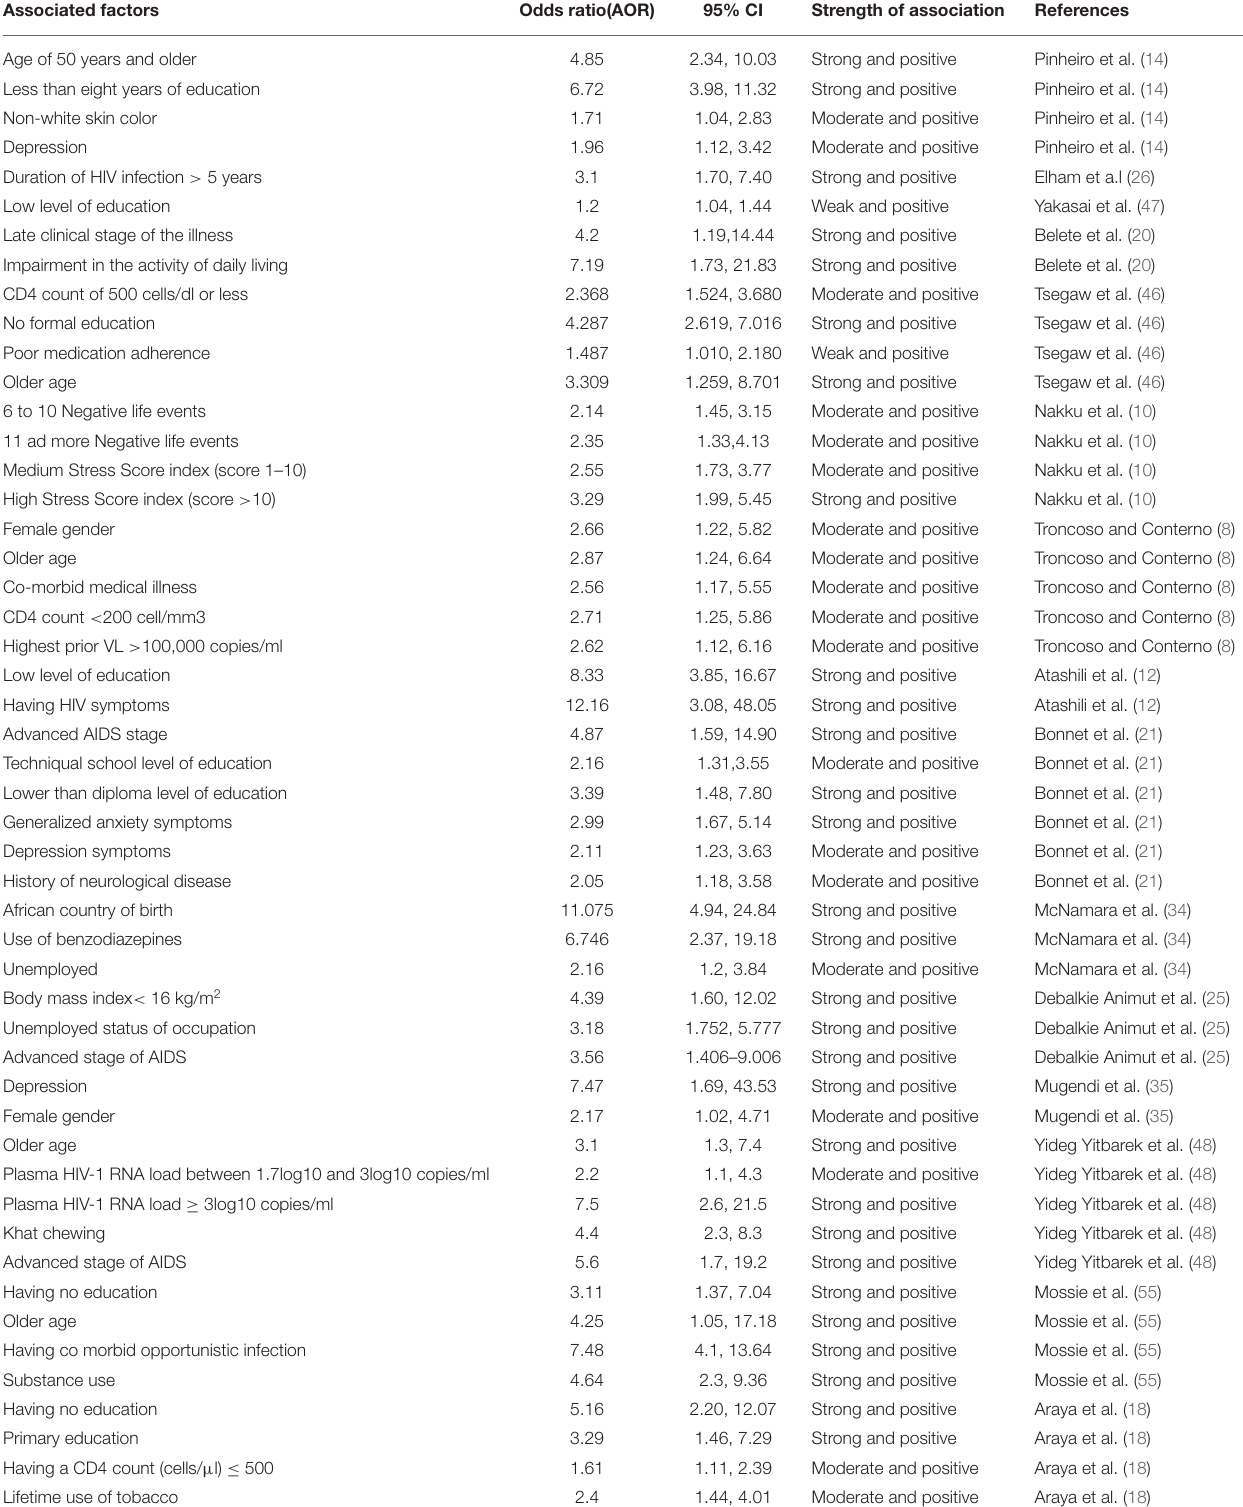
TABLE 3 | Characteristics of associated factors for HIV associated neurocognitive disorders in HIV/AIDS patients by their Odds ratio, Confidence interval, association strength, author and year of publication. Associated factors Odds